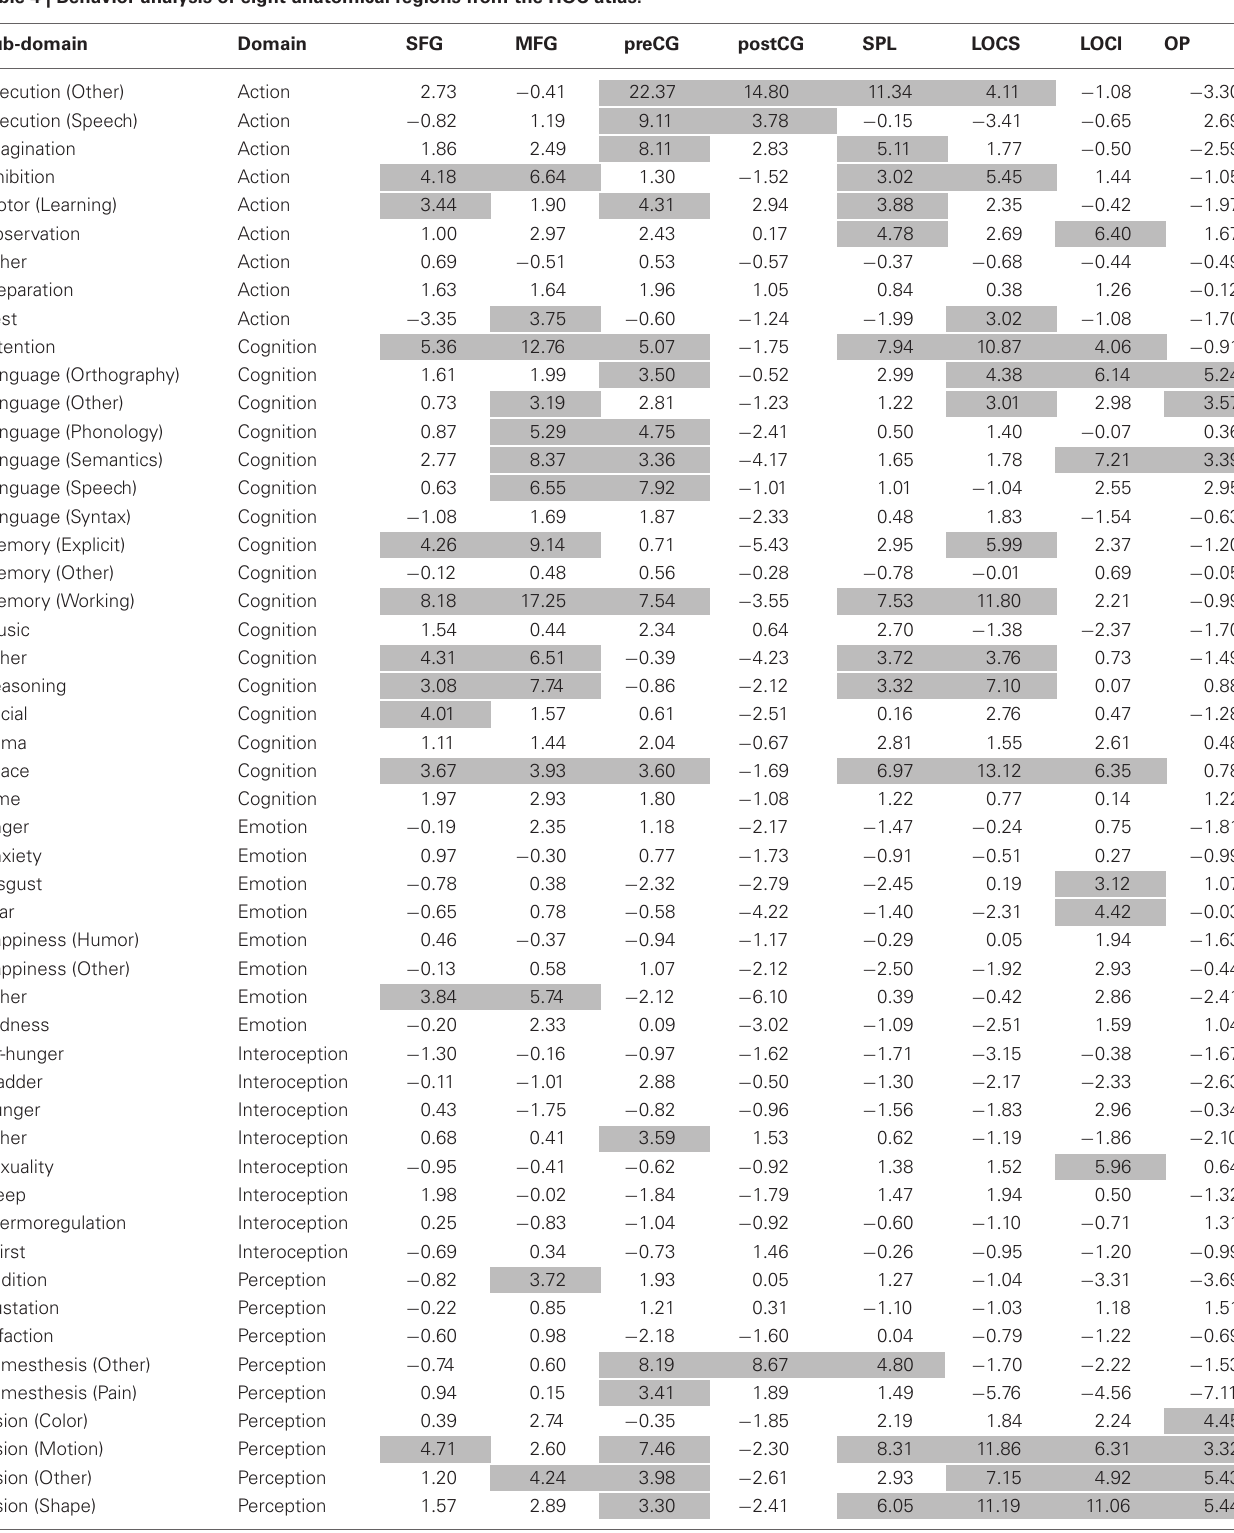
Table 4 | Behavior analysis of eight anatomical regions from the HOC atlas.